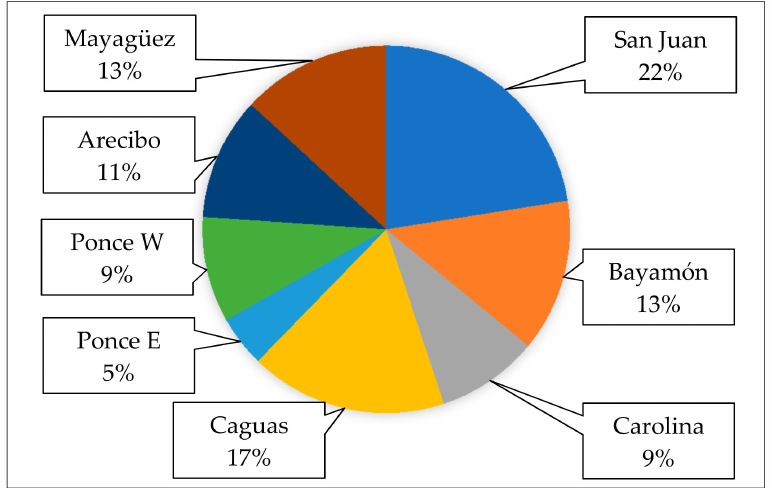
Figure 10. Resultant distribution of electricity consumption in Puerto Rico by region (based on available data from 2010 to